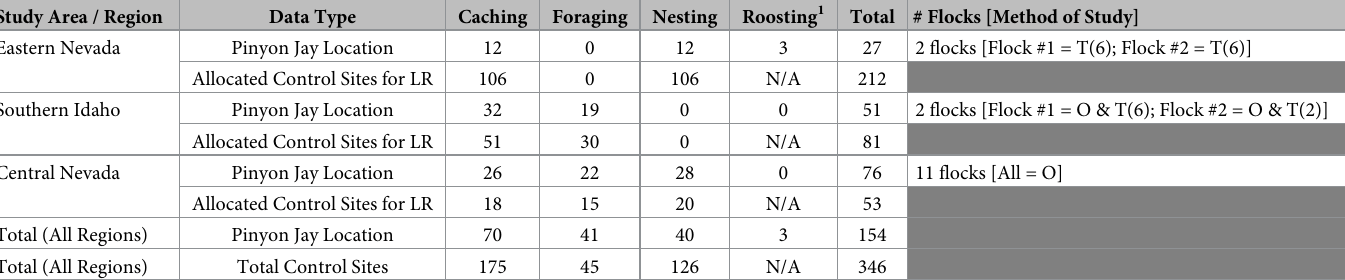
Table 3. Summary of Pinyon Jay locations and control sites.